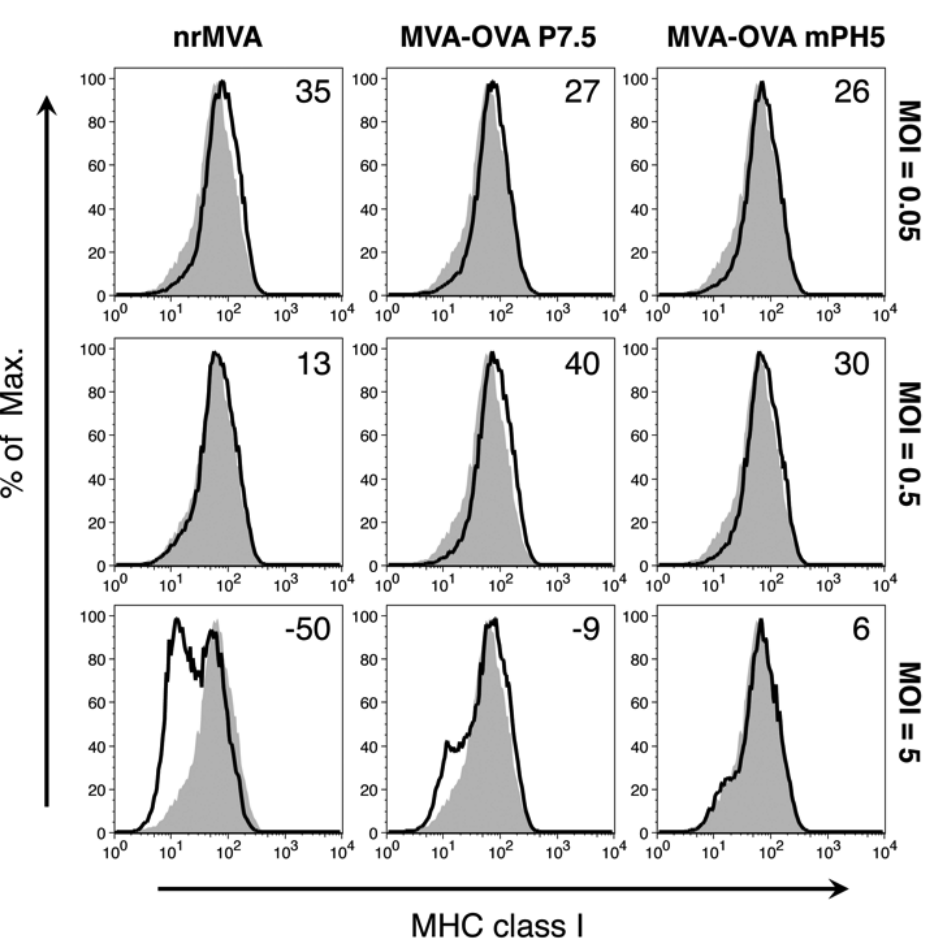
Figure 3. DC expression of MHC class I depends on the MOI of MVA. DCs were infected with nrMVA, MVA-OVA P7.5, and MVA-OVA mPH5 at different MOIs for 6 h. After washing and further incubation for 16 h, changes in the expression of MHC class I were measured by flow cytometry. The MOIs of 0.05, 0.5, and 5 were arbitrarily considered as representative of low, intermediate, and high MOI, respectively (open histograms). Mock infected DCs (MVA = 0, shaded histogram) were considered as a basal level of MHC class I expression. Numbers in the upper right corners indicate fold-changes as